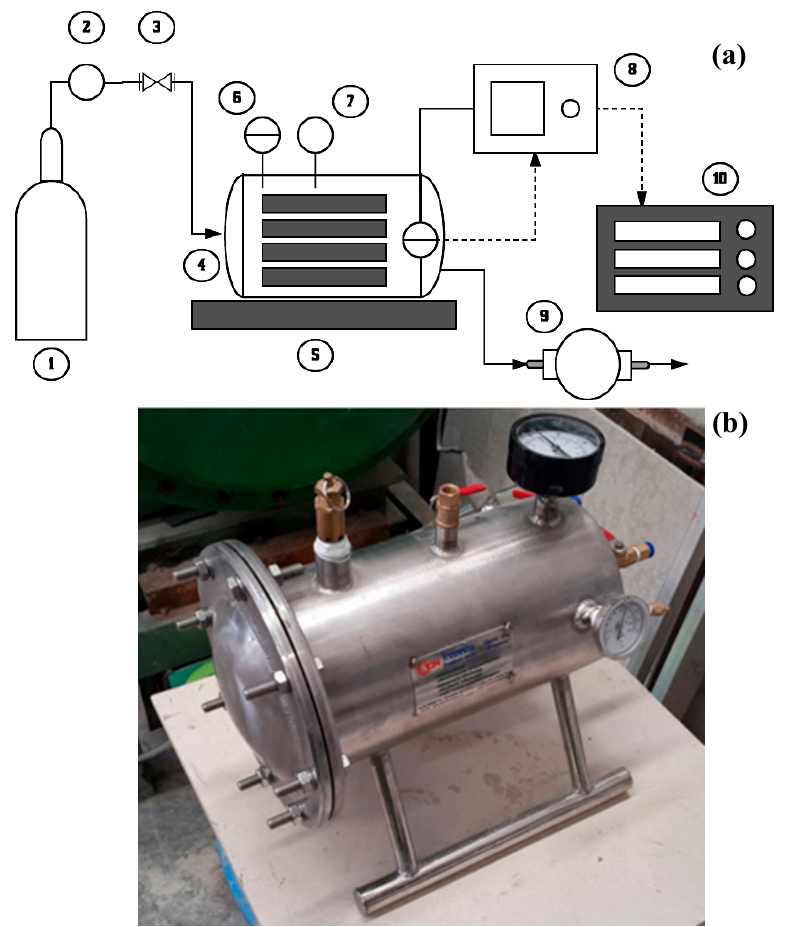
Figure 1. A Schematic setup ( a ) and a photo ( b ) of the accelerated carbonation apparatus: 1. CO 2 gas tank; 2. Flow transmitter; 3. Pressure regulator; 4. Curing chamber; 5. Digital scale; 6. Pressure gauge; 7. Temperature gauge; 8. CO 2 and humidity sensor; 9. Vacuum pump; 10. Data logger.